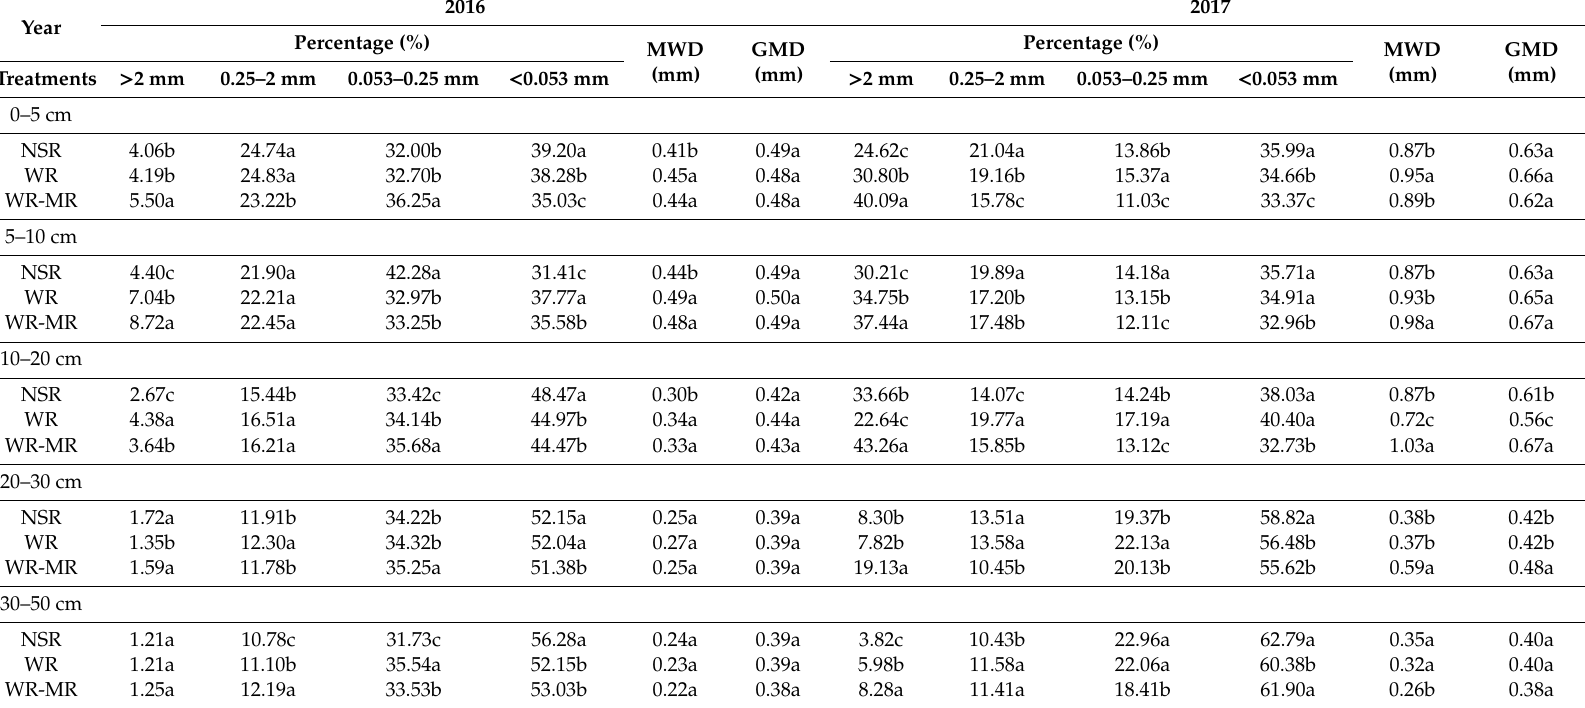
Table 3. E ff ects of straw return modes on aggregate size distribution and